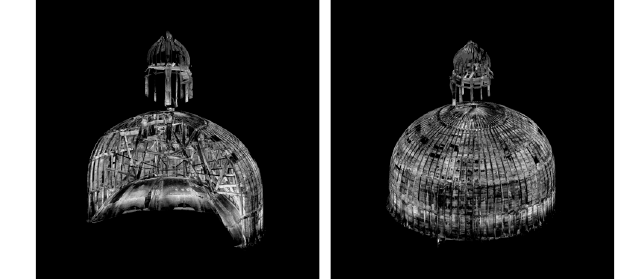
Figure 4. The wooden structure and one of the spherical target that we used for the survey.